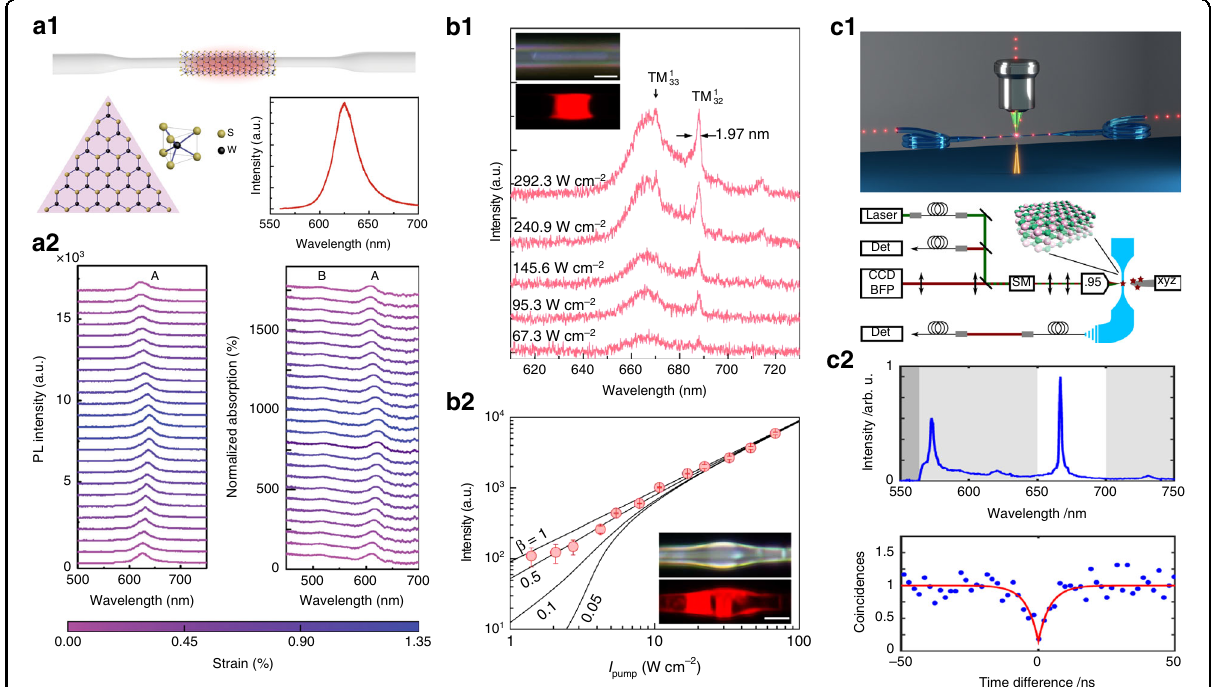
Fig. 4 Light emitters integrated in optical micro fi ber. a1 Schematic hybrid MF-WS 2 structure for enhanced light emission 182 . Inset: Crystal structure of a triangular monocrystalline WS 2 (left panel), and photoluminescence (PL) spectra of a monolayer WS 2 (right panel) 182 . a2 In-line strain manipulation of the PL (left panel) and absorption spectra (right panel) of hybrid MF-WS 2182 . Room-temperature continuous wave lasing from as- photoactivated monolayer MoS 2 in MF resonator ( b1 ) and microbottle resonator ( b2 ) 192 . c1 Coupling quantum emitters of hBN with MF waveguide 211 . c2 Spectra of the light collected through the fi ber (top), and anti-bunching measurements of the light collected through the fi ber (bottom) 211 . a1 – a2 From ref. 182 . Reproduced by permission from Springer Nature: Light: Science & Applications. b1 – b2 Reprinted by permission from AAAS 192 . c1 – c2 From ref. 211 . Reprinted by permission from ACS